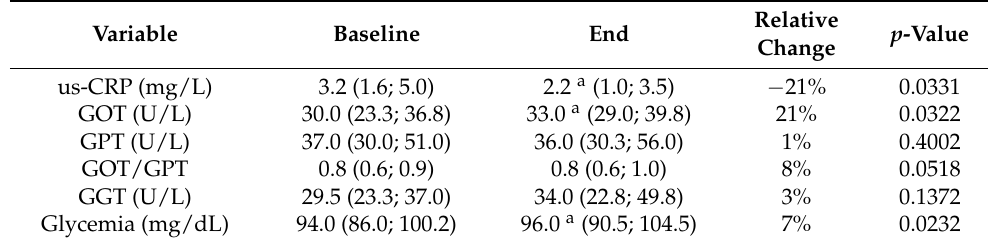
Table 4. Diverse biochemical, anthropometric and vital signs parameters comparisons at baseline and after one year of treatment with sub-micron dispersible